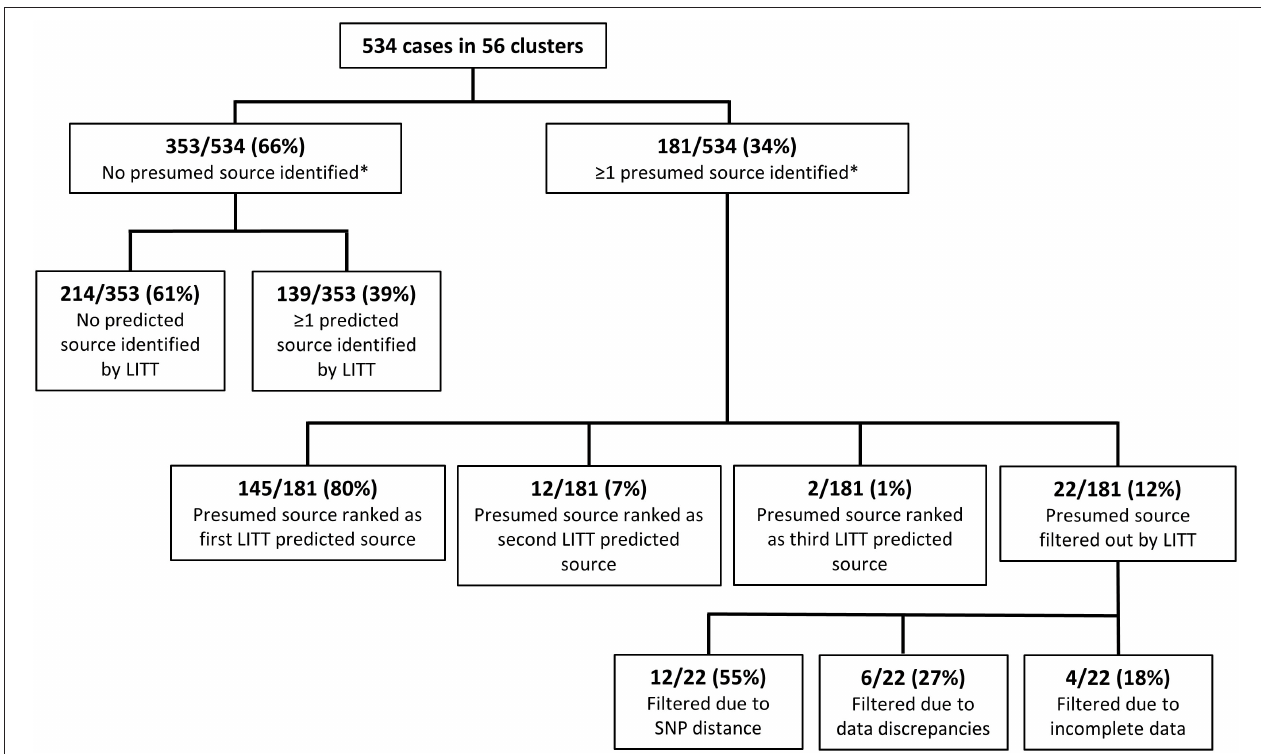
FIGURE 2 | Comparison of the Logically Inferred Tuberculosis Transmission (LITT) algorithm’s predicted source cases to presumed sources identified by local investigators for all 56TB clusters. Shown here are all cases in all clusters. Supplementary Figure 3 splits the results by whether the cluster was in the training